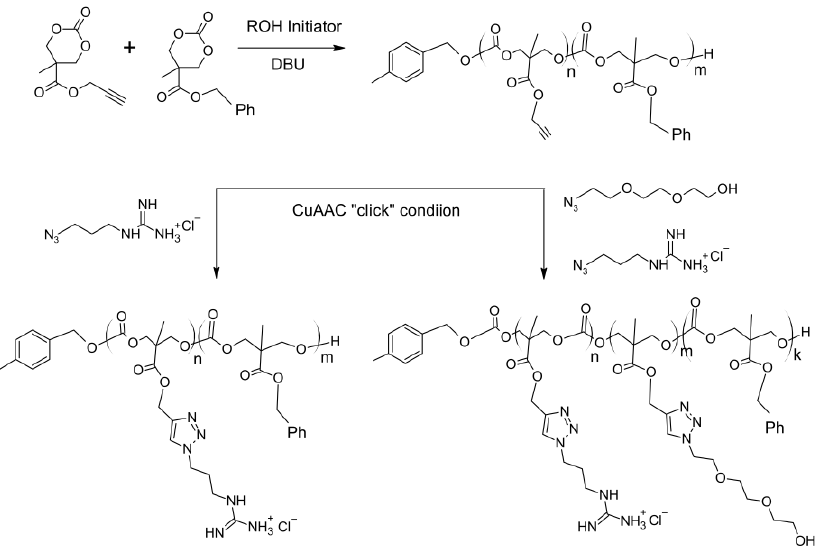
Figure 16. Scheme of synthesis of guanidine functionalized polycarbonate copolymers based on [332].